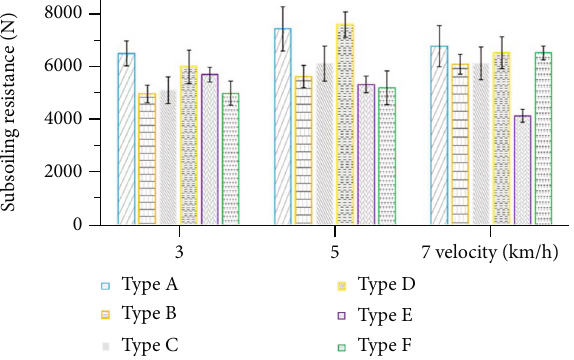
Figure 14: Mean values of subsoiling resistance for six types of subsoilers at three speeds and 30 cm depth.